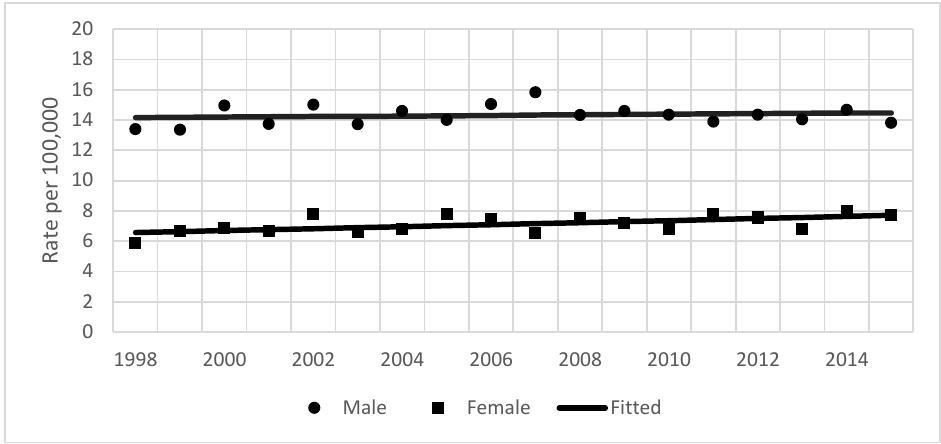
Figure 2. Age-standardized mortality rates from pancreatic cancer by sex in Lithuania from 1993–2012.